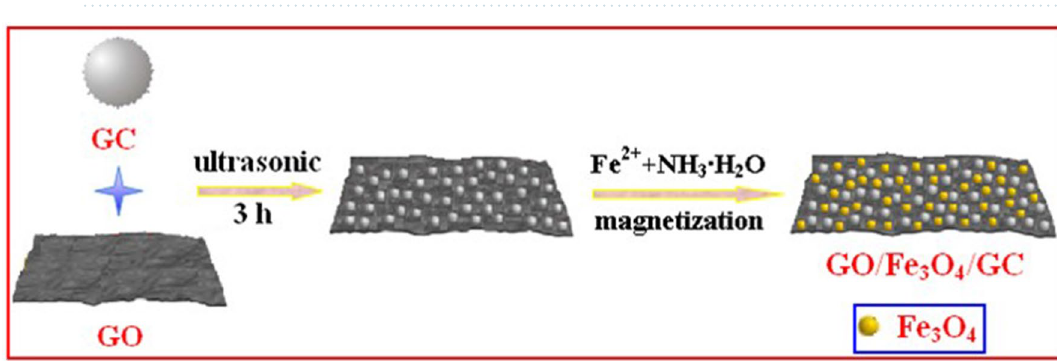
Figure 4. Schematic diagram of a possible formation mechanism of GO/Fe 3 O 4